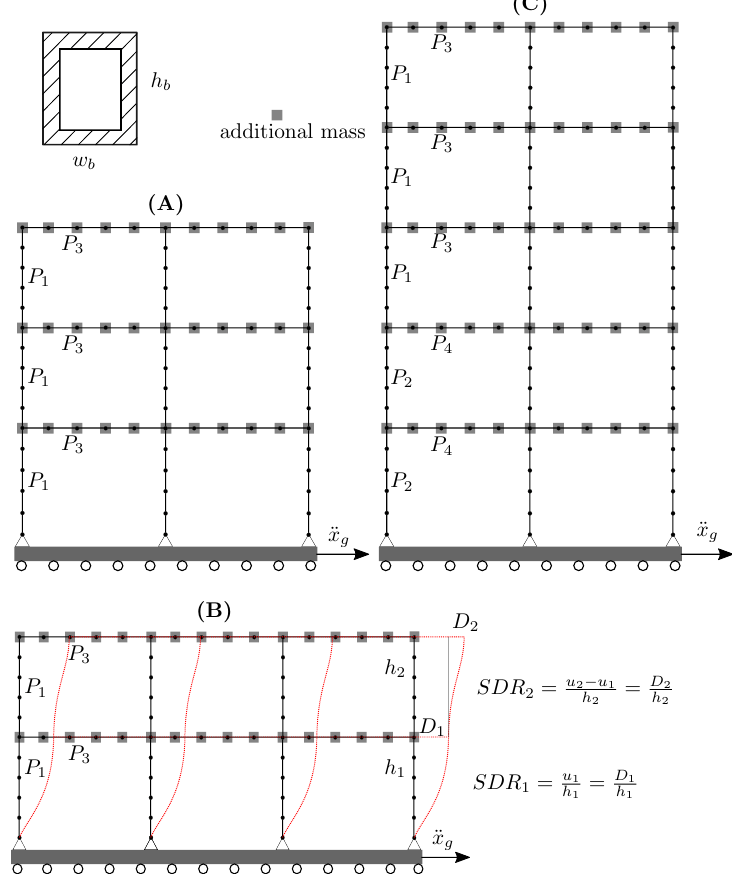
Figure 11. Numerical example to demonstrate the strategy: ( A ) Two-bay-tree-story frame structure; ( B ) three-bay-two-story frame structure; ( C ) two-bay-five-story frame